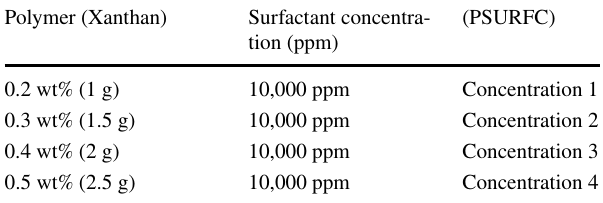
Table 4 Polymeric surfactant (PSURFC)